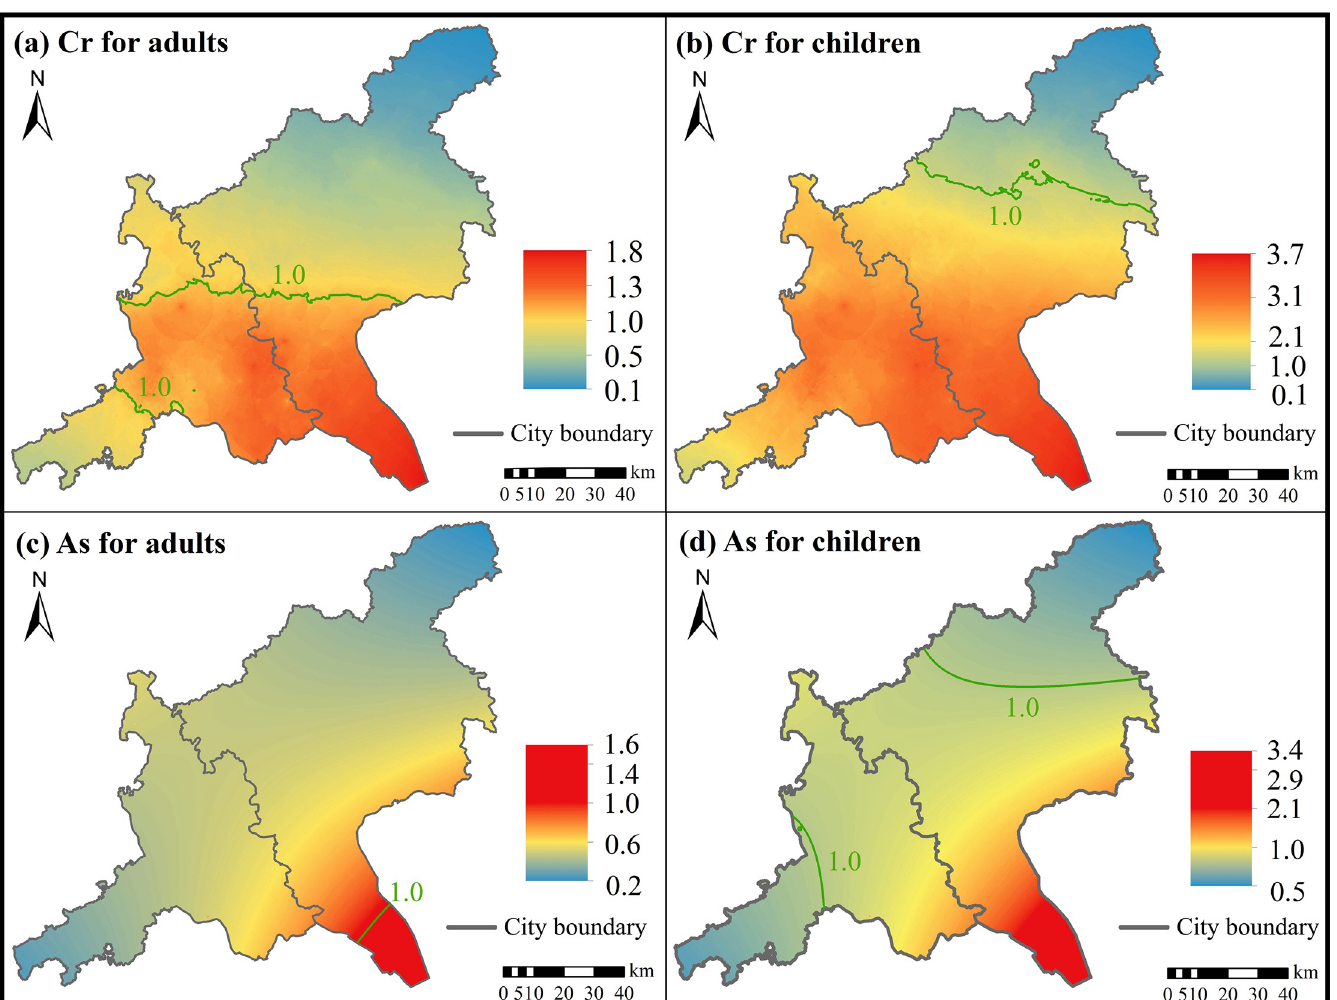
Fig 6. Spatial distribution of estimated HQ values. Cr for (a) adults and (b) children, As for (c) adults and (d)